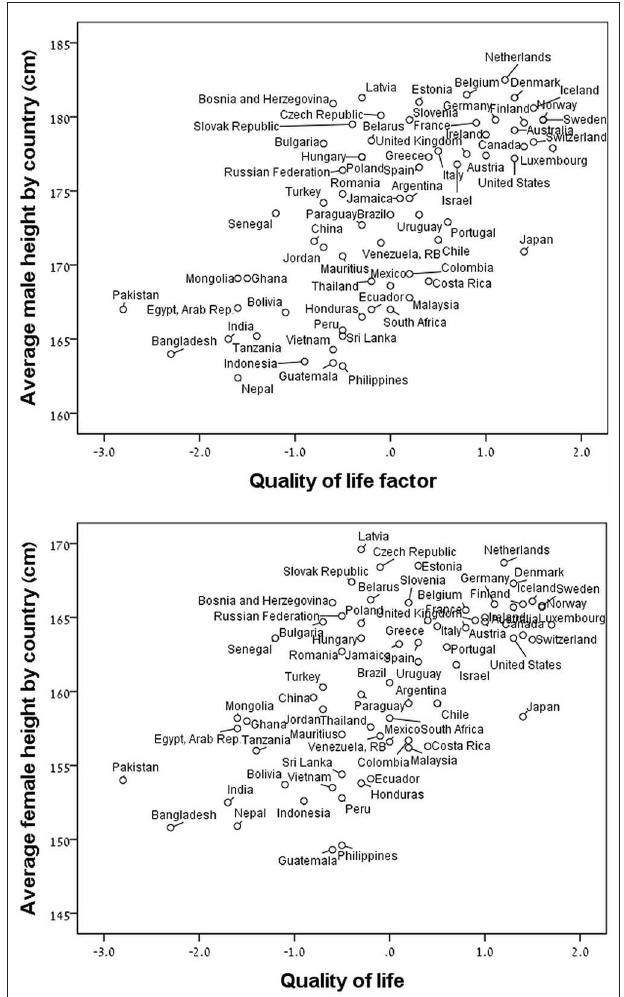
FIGURE 1 | Average height by country as a function of the quality of life factor (Z-score) for males (upper panel; r = − 0.65, p < 0.0001) and for females (lower panel; r = − 0.60, p <